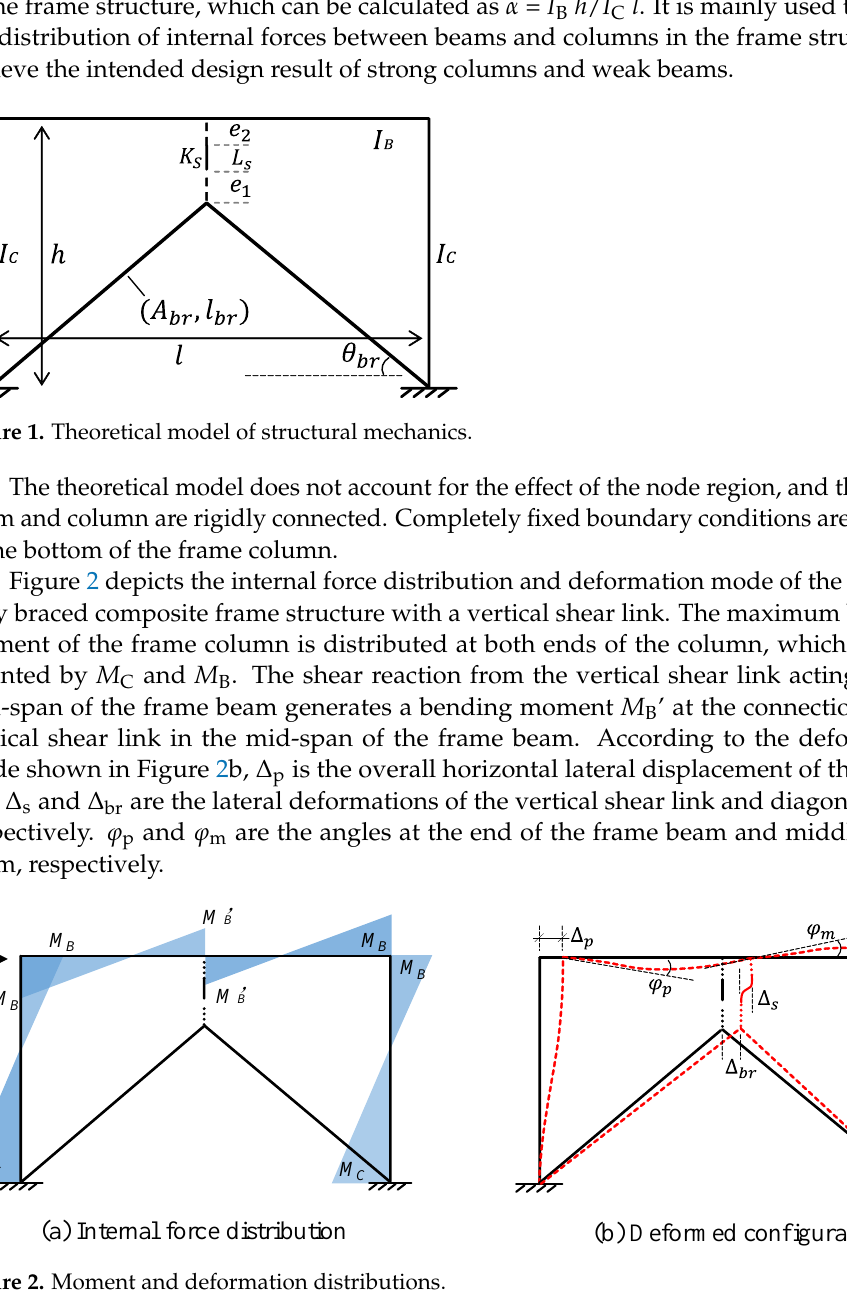
Figure 2. Moment and deformation distributions.